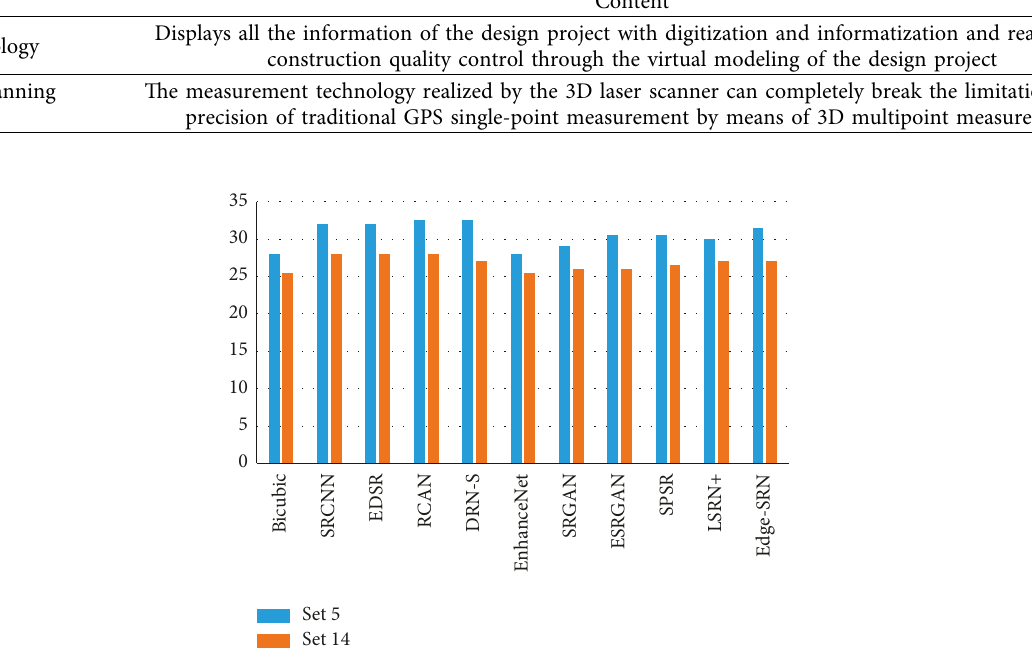
Figure 2: Recognition features of super-resolution images by different network models.